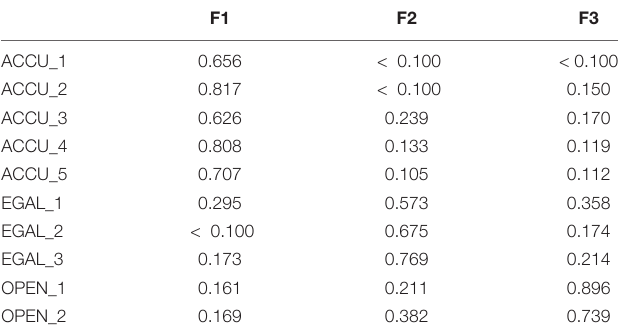
TABLE 4 | Exploratory factor